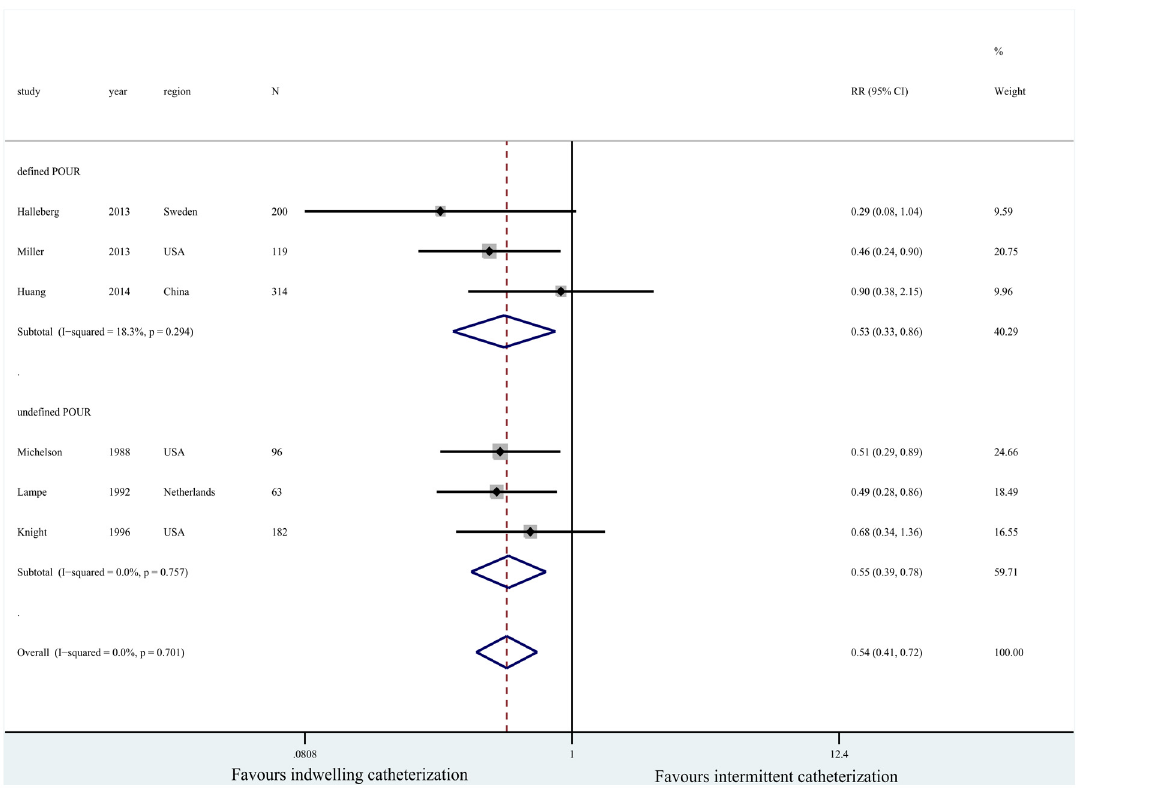
Fig 4. Forest plot for postoperative urinary